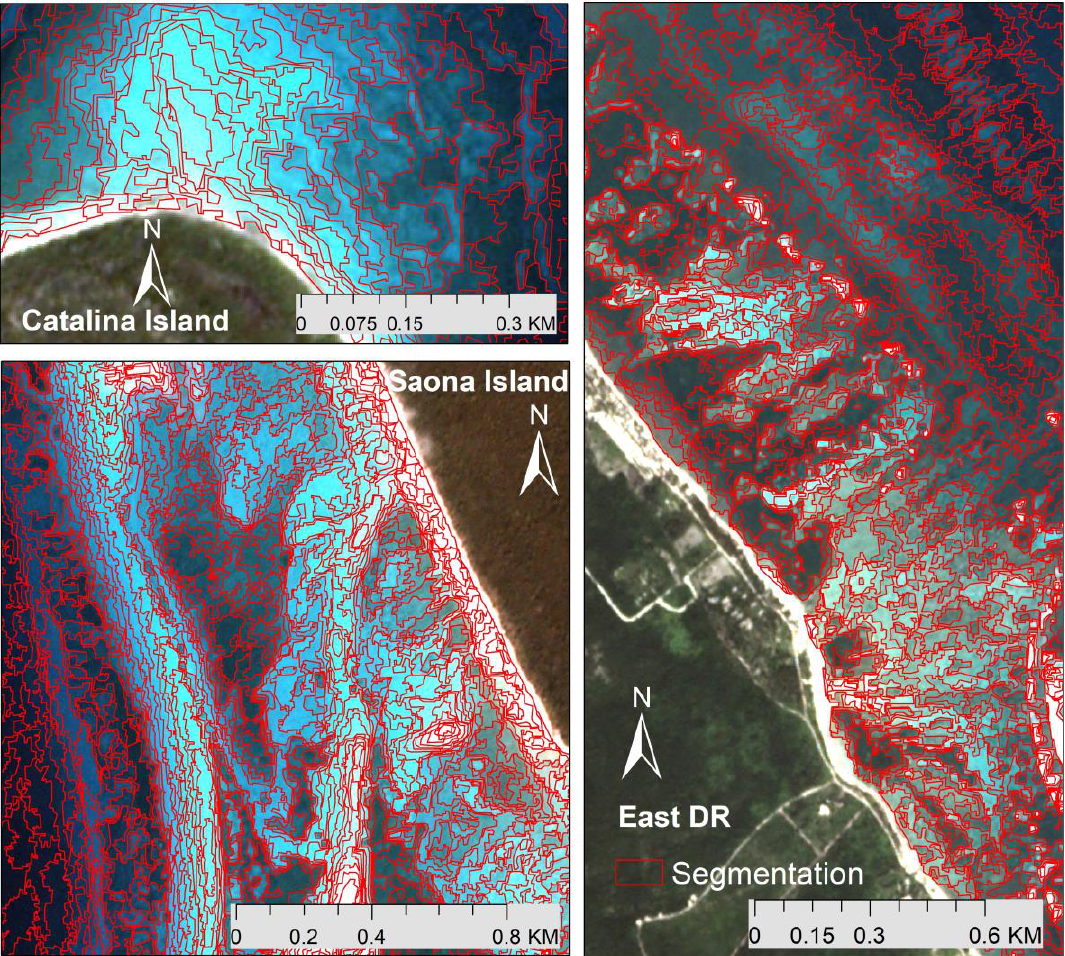
Figure 4. Image segmentation results of benthic features within the three study sites.